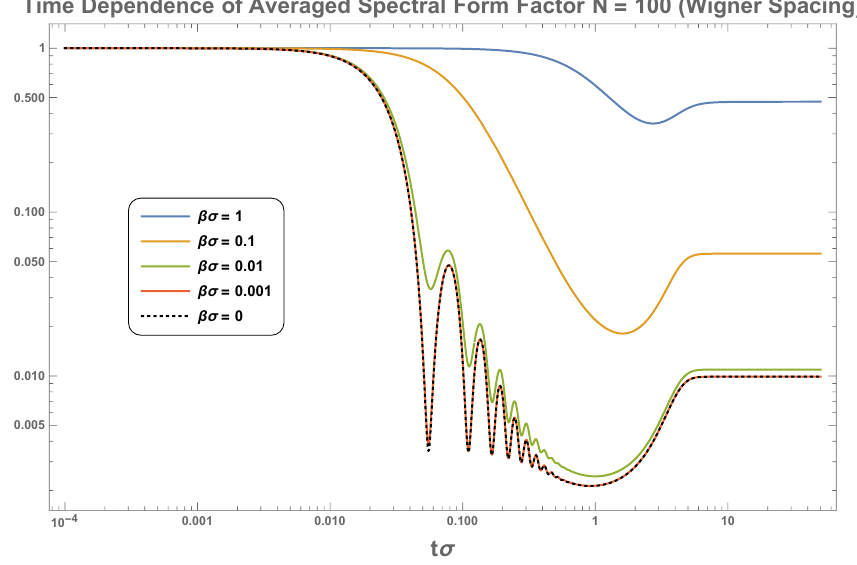
Figure 7 . Above is a Log-Log plot of the averaged spectral form factor of a spectrum generated by the i.i.d model with Wigner surmise NNS distribution for the GUE given by eq. (3.13). We fixed the value of N = 100 and plot the averaged form factor for different